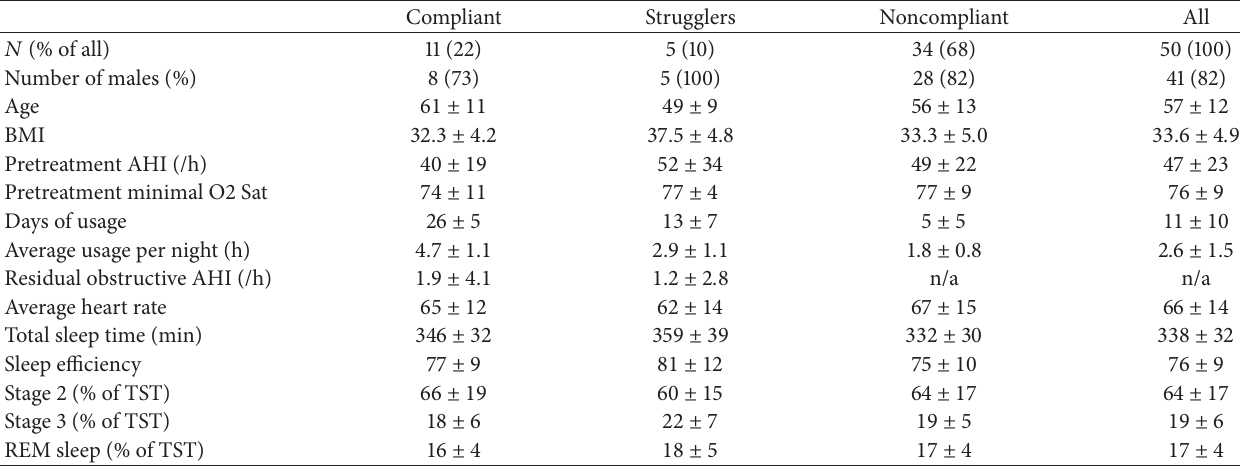
Table 1: Data categorized according to compliance with CPAP.